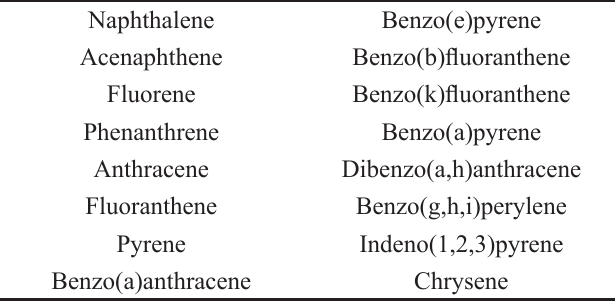
TABLE I - Examples of light and heavy polycyclic aromatic hydrocarbons most frequently evaluated in environmental studies